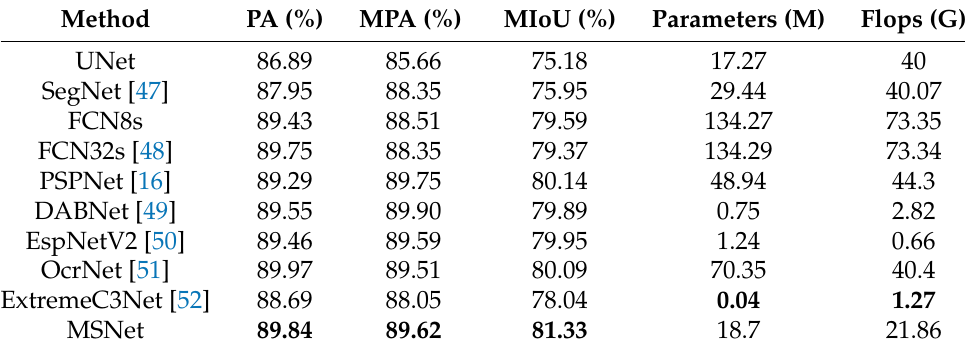
Figure 12. Feature space analysis of MSNet: ( a ) real Image; ( b ) thermodynamic diagram Table 3 shows the evaluation metrics of each model, and the PA represents the pixel accuracy of each category in the three categories. In comparison with FCN-32s, SegNet, DABNet, UNet [33], EspNet [46], ShuffleNetv1 [20], and the other models, MSNet was able to achieve the best results, which were 1.19% higher than the second best index. Table 3. Results of the land-cover test